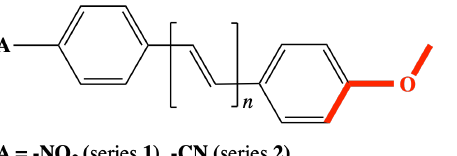
Figure 1. Molecules studied in the present work and their labeling. Dihedral angle (in red) is 180 and 0 deg for conformers I and II ,